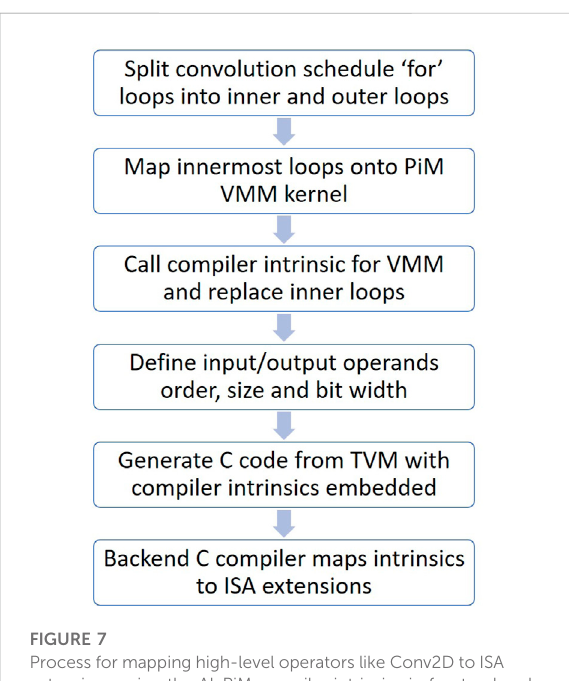
FIGURE 7 Process for mapping high-level operators like Conv2D to ISA extensions using the AI-PiM compiler intrinsics in frontend and backend